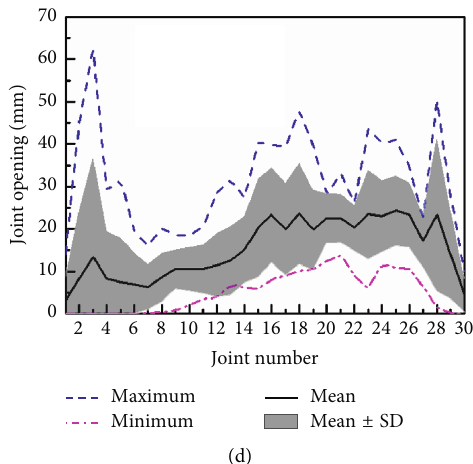
Figure 15: Joint opening distributions at different PGAs: (a) 0.3 g; (b) 0.6g; (c) 0.9g; (d)